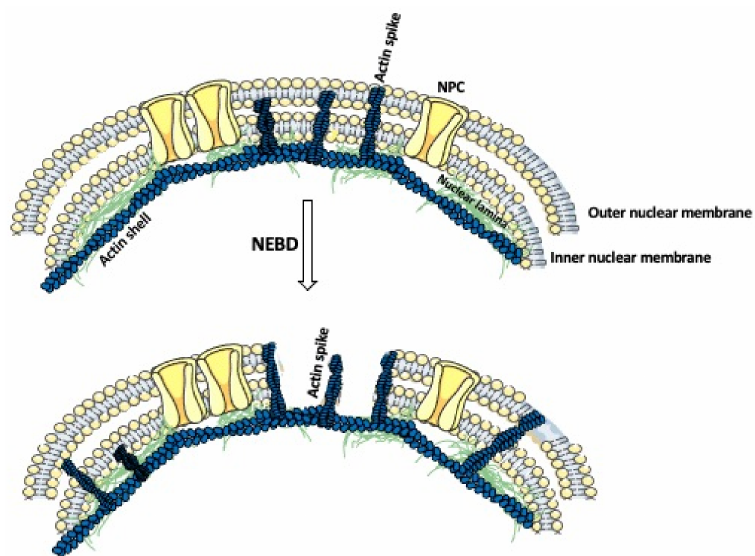
Figure 2. Actin’s role in the nuclear envelope breakdown. The nuclear envelope is composed of a double nuclear membrane and an underlying nuclear lamina. Prior to the nuclear envelope breakdown (NEBD), the actin shell polymerizes within the nuclear lamina. This is followed by the formation of the actin spikes, which displace the nuclear pore complexes (NPCs), and penetrate and fragment the nuclear